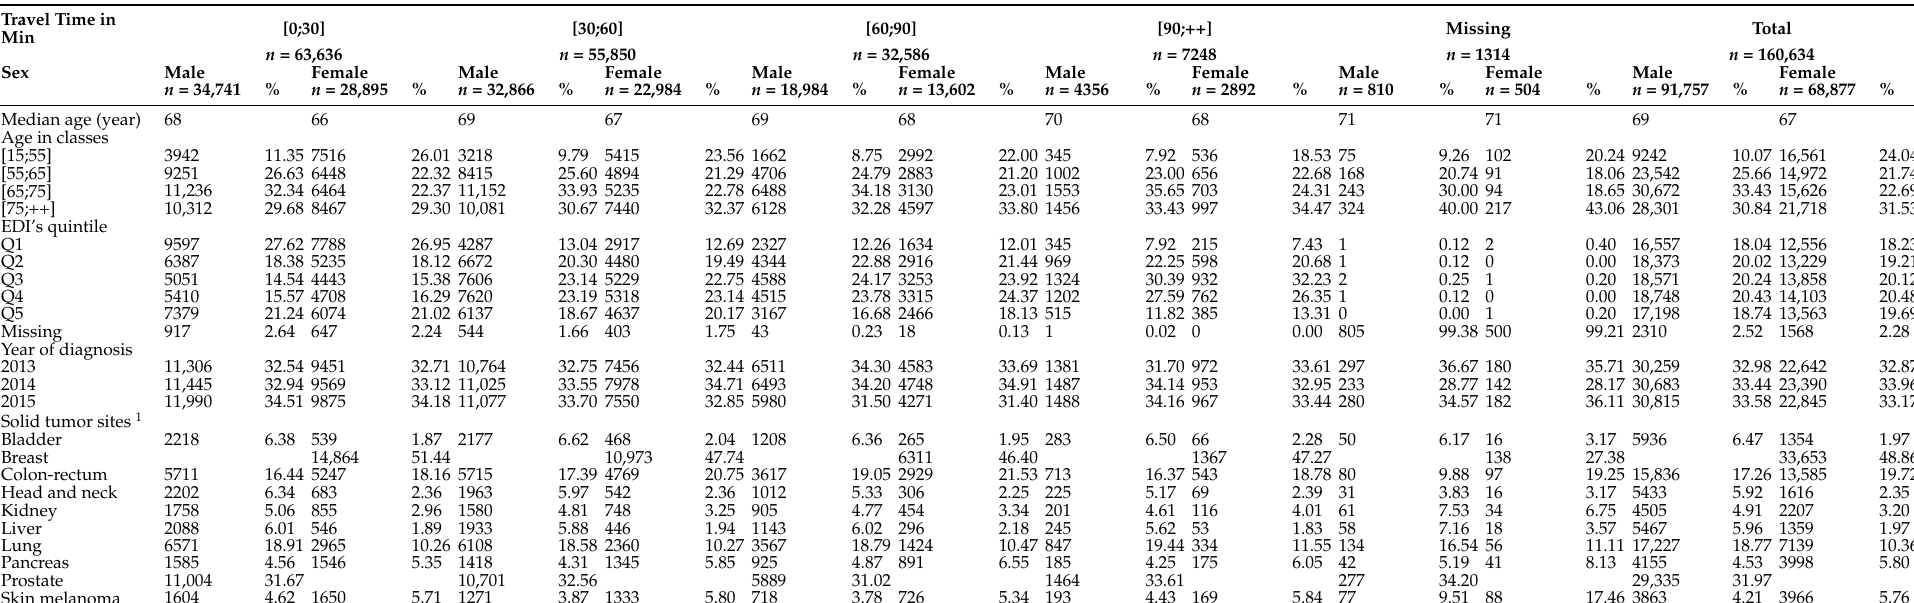
Table 1. Characteristics of